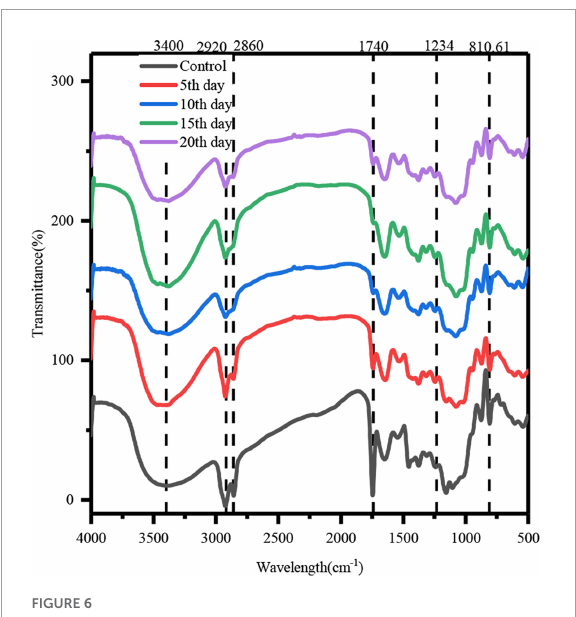
FIGURE7 X-ray diffraction (A) and crystallinity (B) of COC at different treatment times. ∗∗∗∗ p -value <